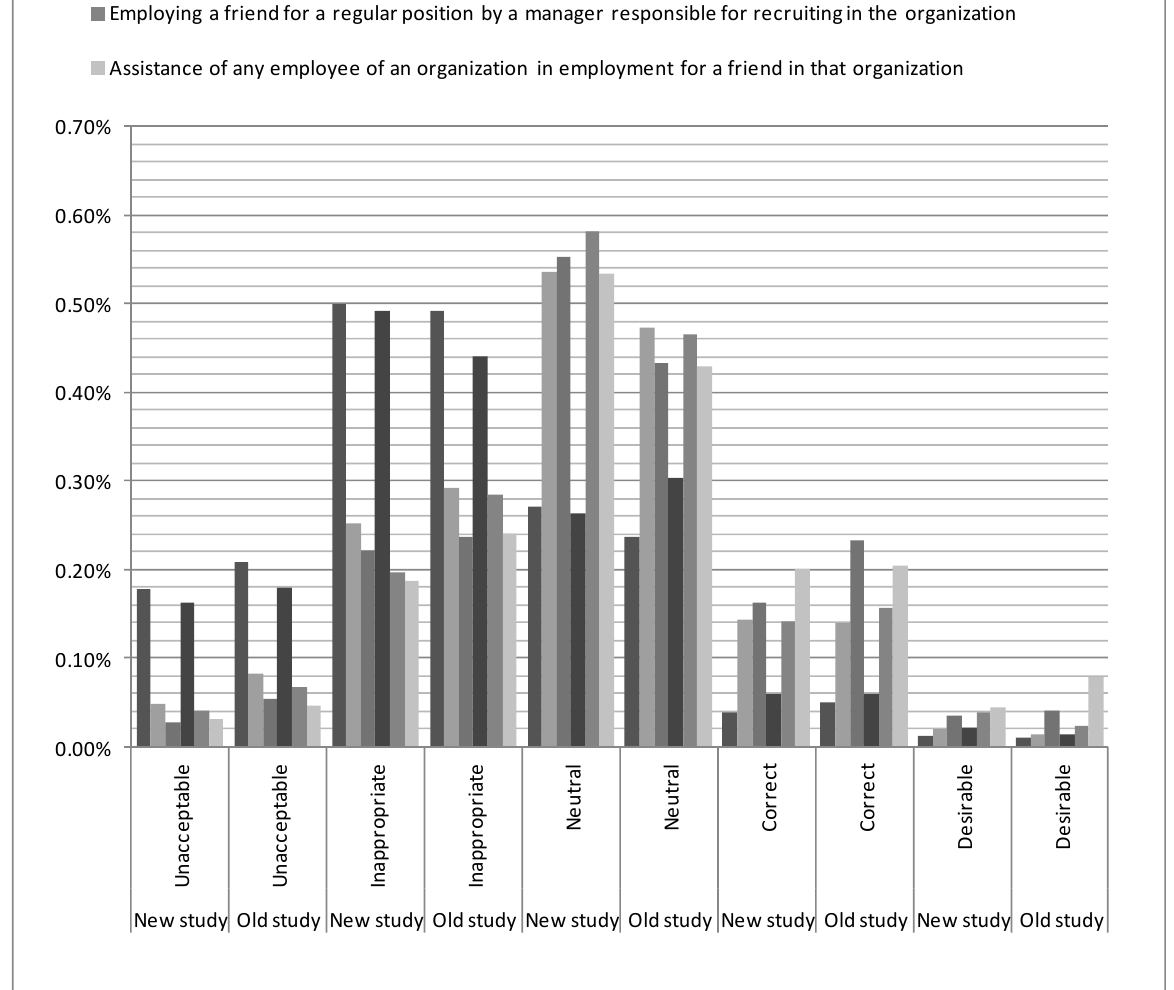
Figure 2. Assessment of employment situations with the use of nepotism and cronyism in a non-family business. Source: authors’ own elaboration.